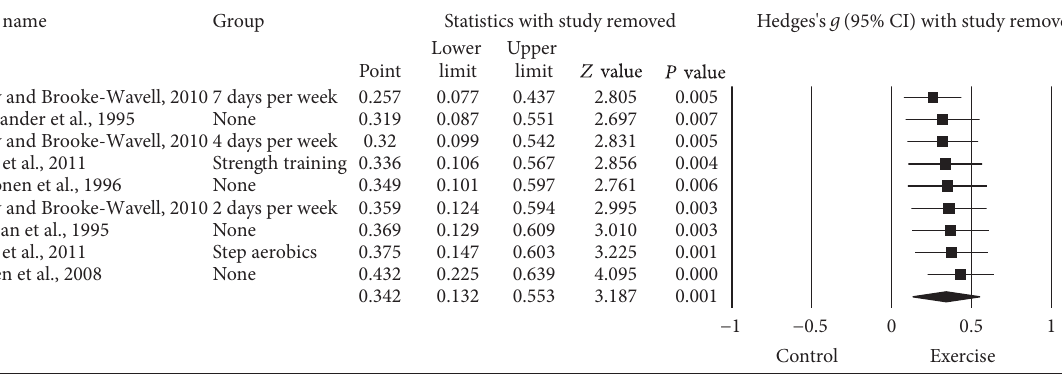
F 3: In�uence analysis for changes in FN BMD. In�uence analysis for point estimate standardized effect size changes ( with each corresponding study deleted from the model once. e black squares represent the standardized mean difference ( le and right extremes of the squares represent the corresponding 95 the overall standardized mean difference ( intervals. Results are ordered from smallest to largest values of groups. Variable